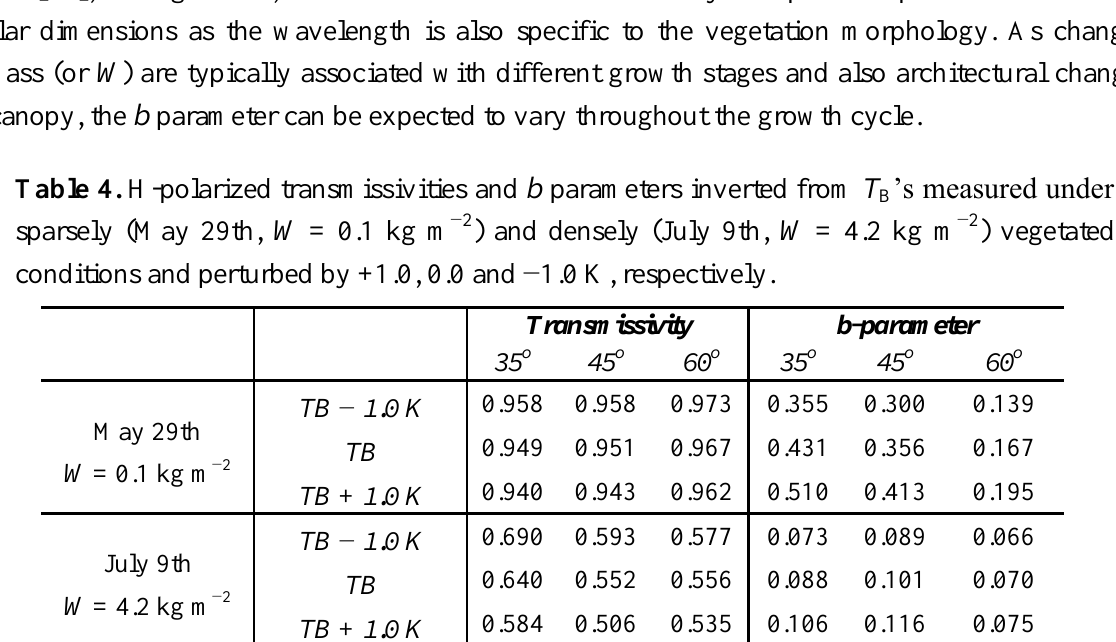
‘s measured under B